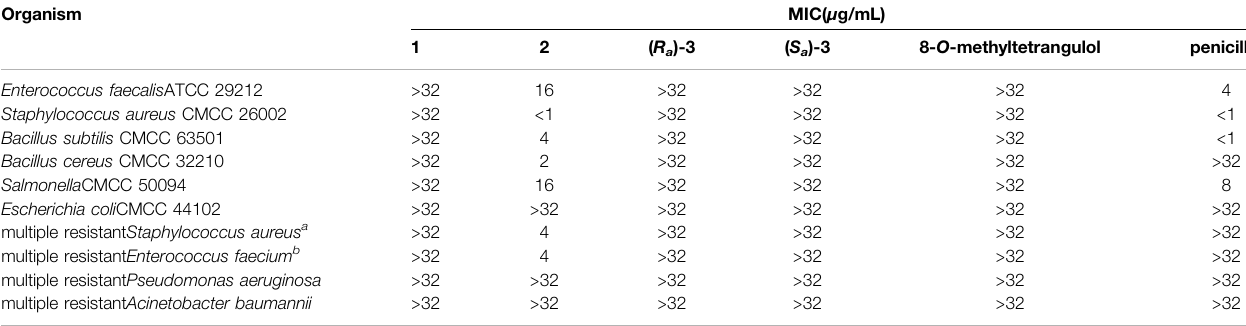
TABLE 2 | In vitro antibacterial activity (MIC in μ g/ml) of compounds 1 – 3 and 8- O -methyltetrangulol. Organism